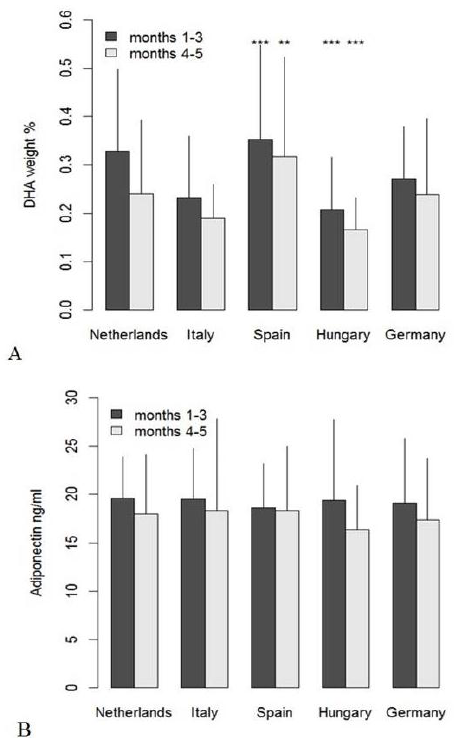
Figure 2. Mean values (+SD) of docosahexaenoic acid (DHA) weight% ( A ) and adiponectin concentration ( B ) per country in early and late milk samples; significant differences from the global means for DHA (months 1–3: 0.29%, months 4–5: 0.24%) and adiponectin (months 1–3: 19.3 ng/mL, months 4–5: 17.6 ng/mL) are indicated as ** for p < 0.01 and *** for p < 0.001. Table 5. Human milk fatty acid composition found in the late samples according to the country of residence of the